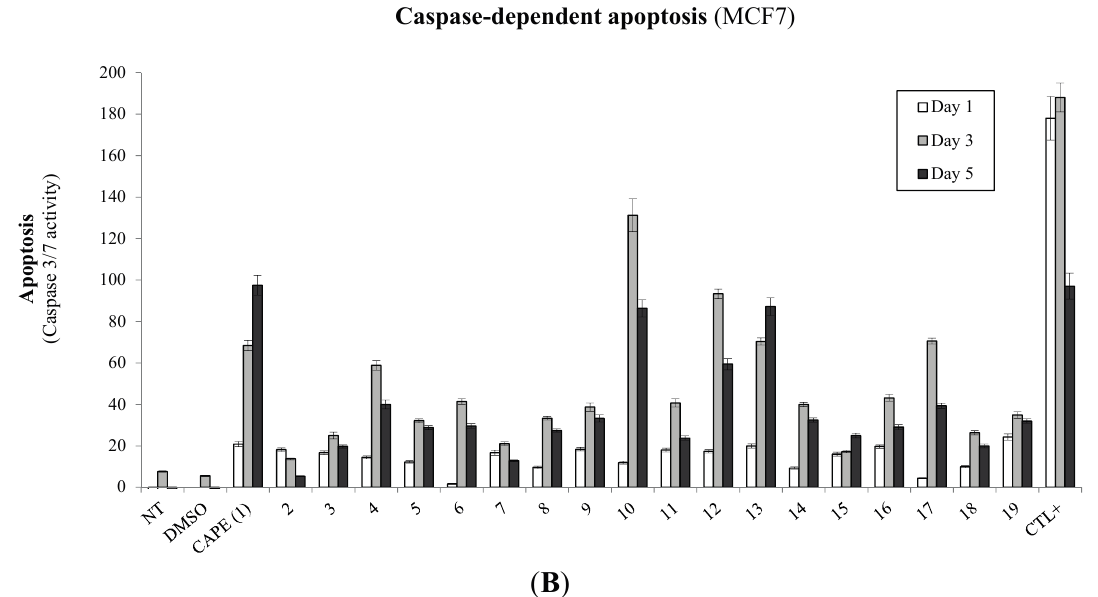
Figure 2. Biological effects of CAPE derivatives on breast cancer cells. MCF7 breast cancer cells were treated with 10 µM of selected compounds and incubated in time (24, 72 and 120 h) and evaluated for ( A ) cell viability assay (Cell-Titer Blue, Promega) or ( B ) caspase-dependent apoptotic events (Apo-ONE, Promega). Control samples include non-treated (NT) and solvent (DMSO) treated cells in addition to cells treated with apoptosis-inducing agent Melphalan (5 µM) as a positive control (CTL+). Results and standard deviations are representative of biological and experimental triplicates where the data is presented as the means ±